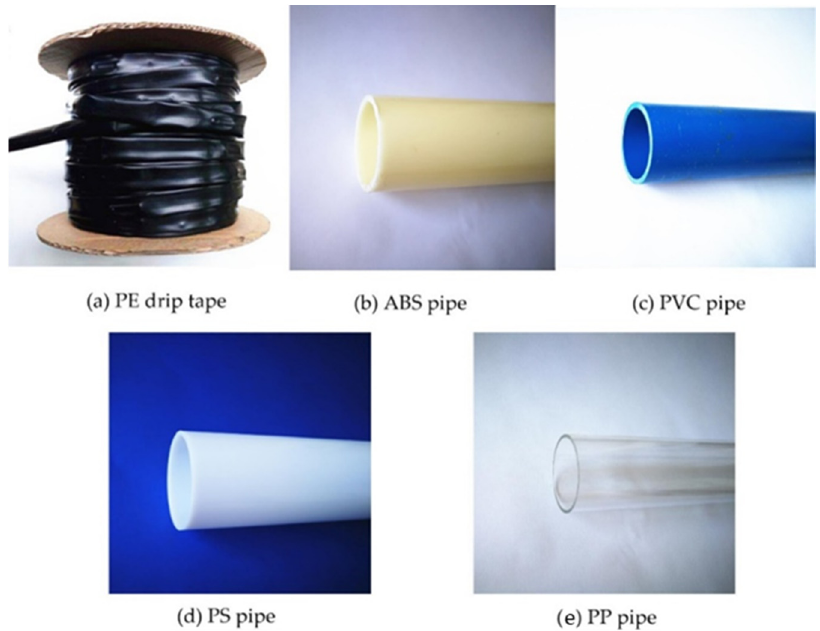
Figure 3. Five types of pipes used in the experiments.